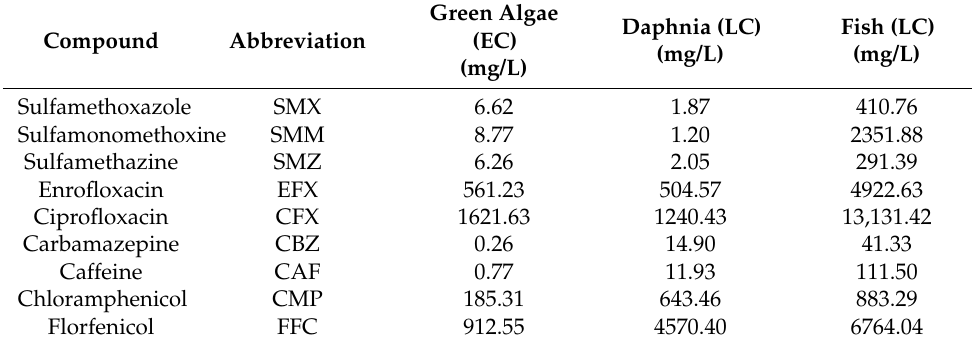
Table 1. The EC or LC of PPCPs to aquatic